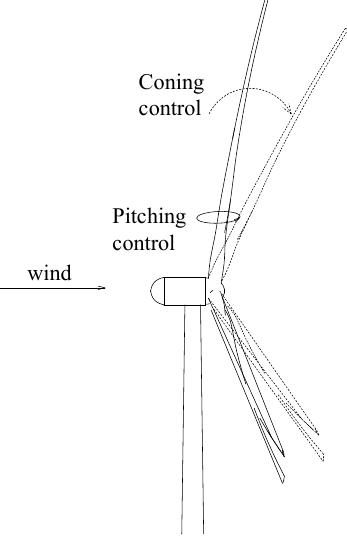
Figure 1. Schematic of pitching control and coning control.